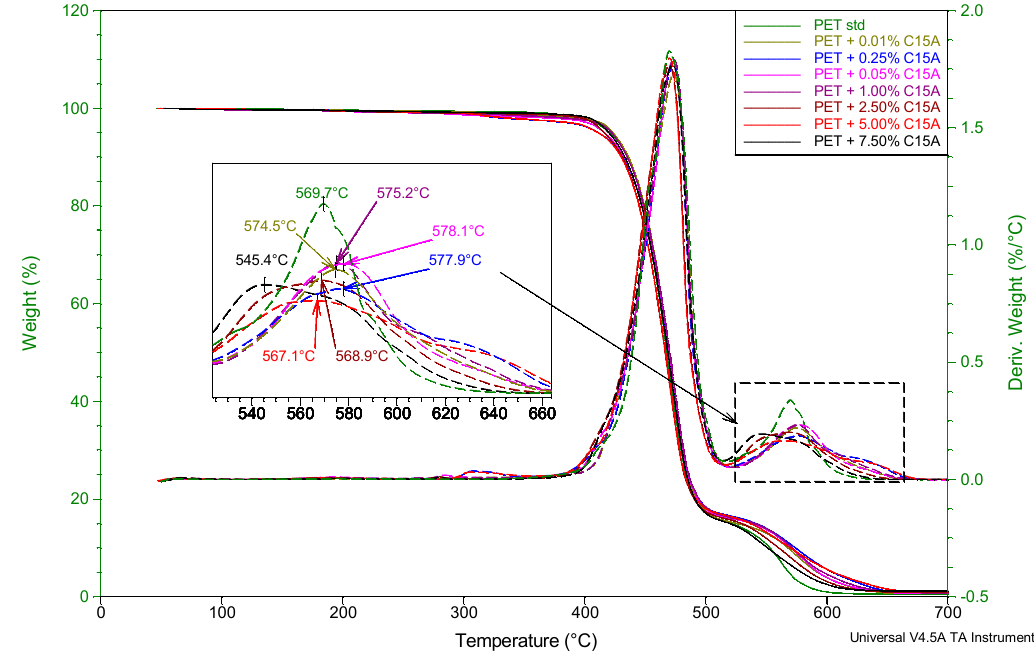
Figure 1. TG and DTG curves of polyethylene terephthalate (PET) fibers modified with Cloisite ® 15A in the bath at 130 ◦ C. Heating rate 20 ◦ / min, purge air flow 60 mL / min. Along with the further increase of the modifier content, which was tested up to 7.5% of C15A, the opposite tendency was observed, i.e., the shift of the discussed maximum towards lower temperatures. The obtained results clearly substantiate the results of the LOI tests and indicate a real improvement of the flame retardancy of the tested PET fibers.